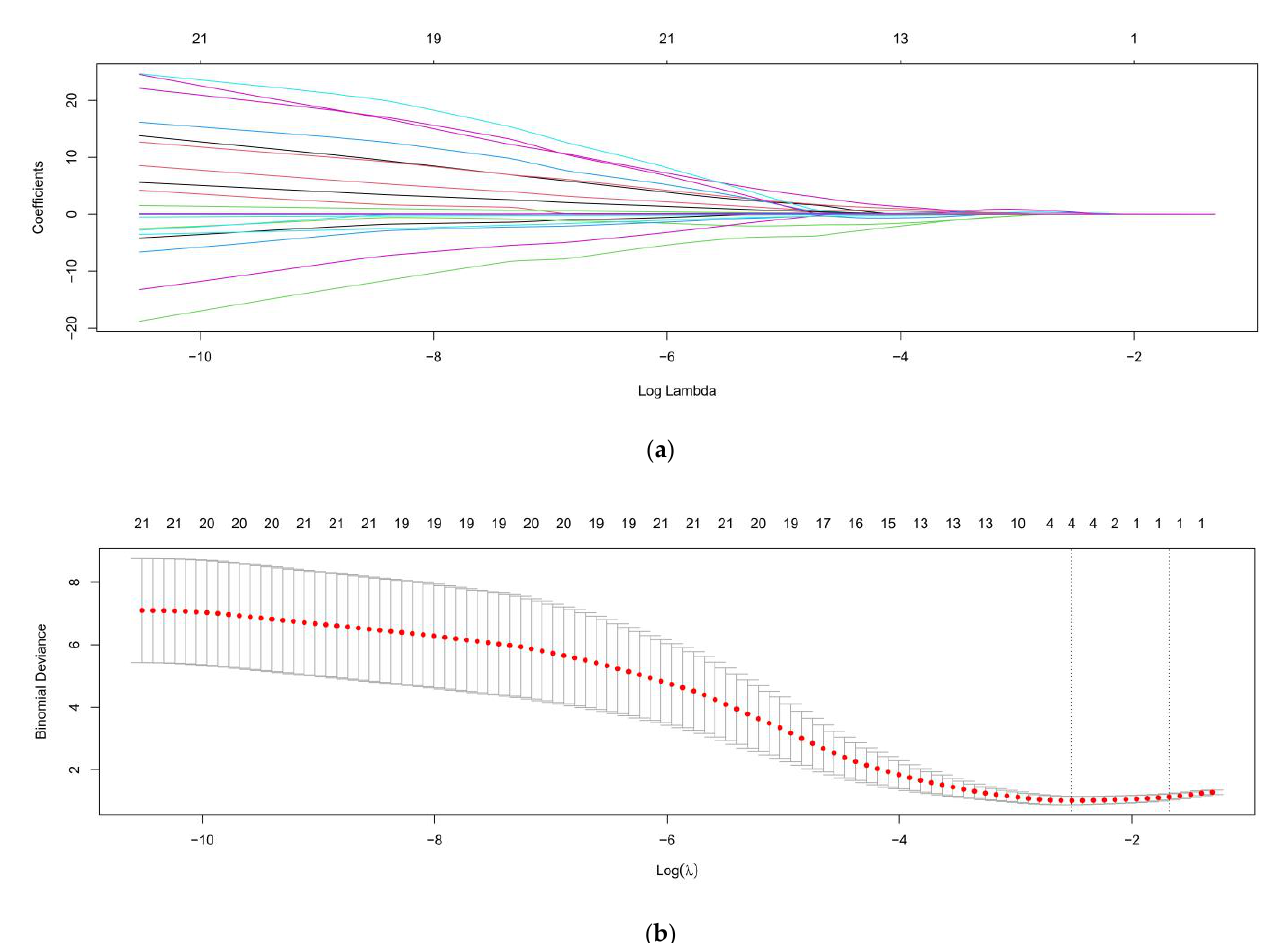
Table 2. Backward stepwise multivariable logistic regression model for postoperative leakage .